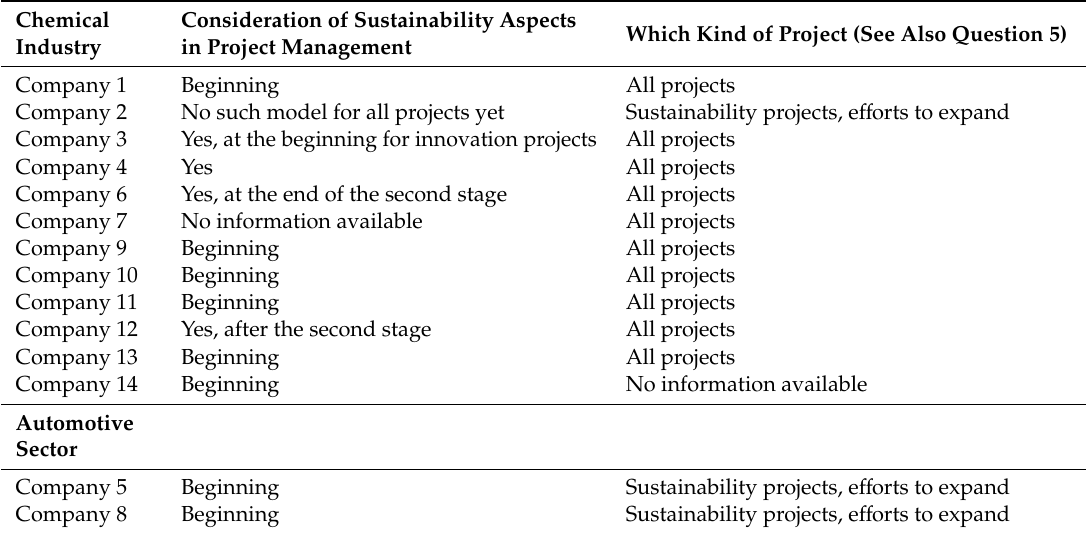
Table 9. Results of question 13 on if and when sustainability aspects are considered in project management processes and for which kind of